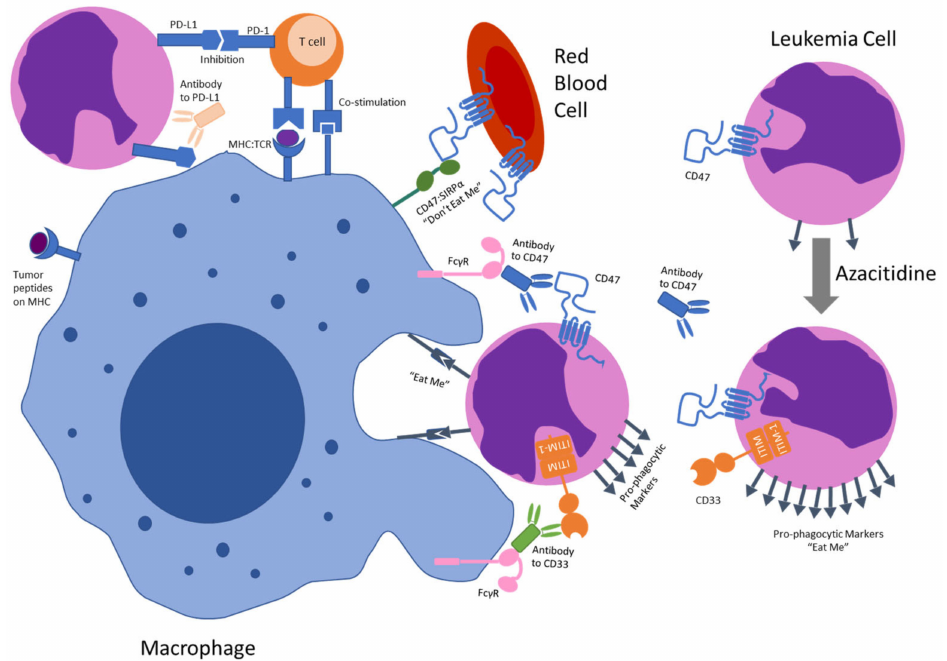
Figure 2. Proposed Mechanisms of Targeting CD47. CD47 blockade decreases the